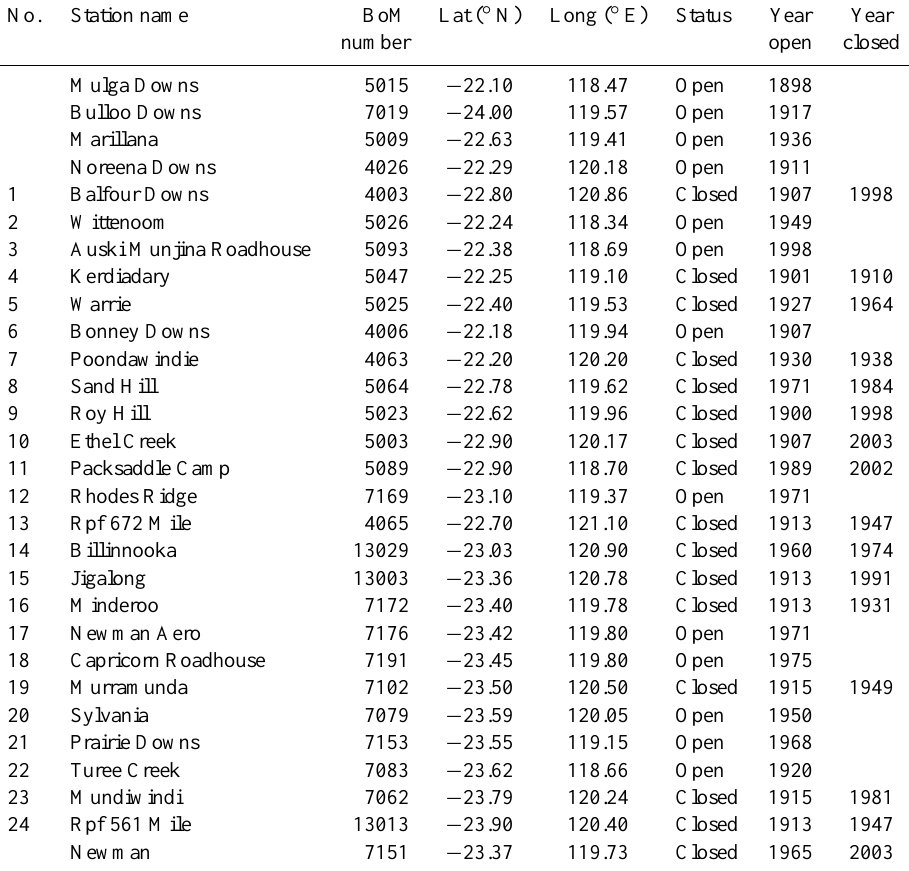
Table A2. Australian Bureau of Meteorology (BoM) rainfall stations (http://www.bom.gov.au/climate/data/) located within and nearby the upper Fortescue River catchment, NW